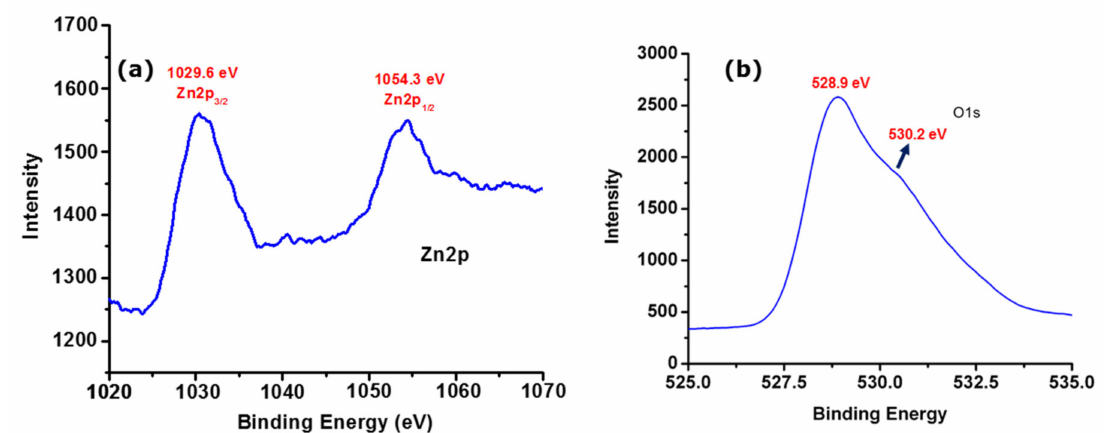
Figure 5. The X-ray photoemission spectra show ( a ) Zn 2p and ( b ) O 1s of as-obtained ZnONPs.